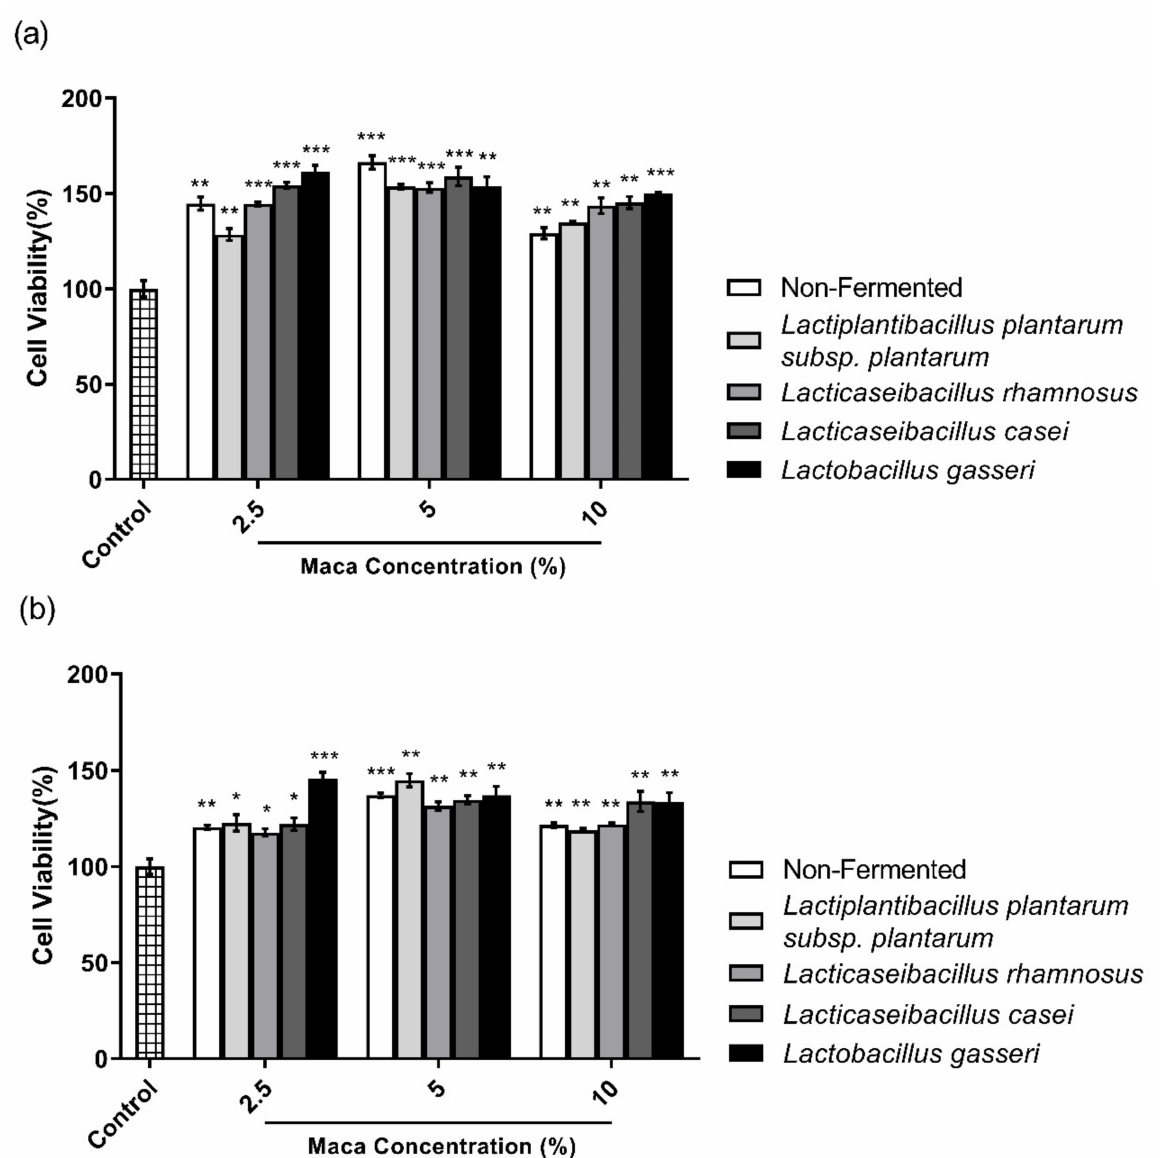
Figure 3. Cell viability of non-fermented and fermented maca root extracts on the RAW 264.7 cell line. Non-fermented and fermented maca root extracts’ effects on the cell viability of RAW 264.7 cells were examined for ( a ) 24 h and ( b ) 48 h using CCK-8 reagent. The results shown are the averages of triplicate samples. Error bars, mean ± SD. * p < 0.05, ** p < 0.005, *** p < 0.0005 compared to the control